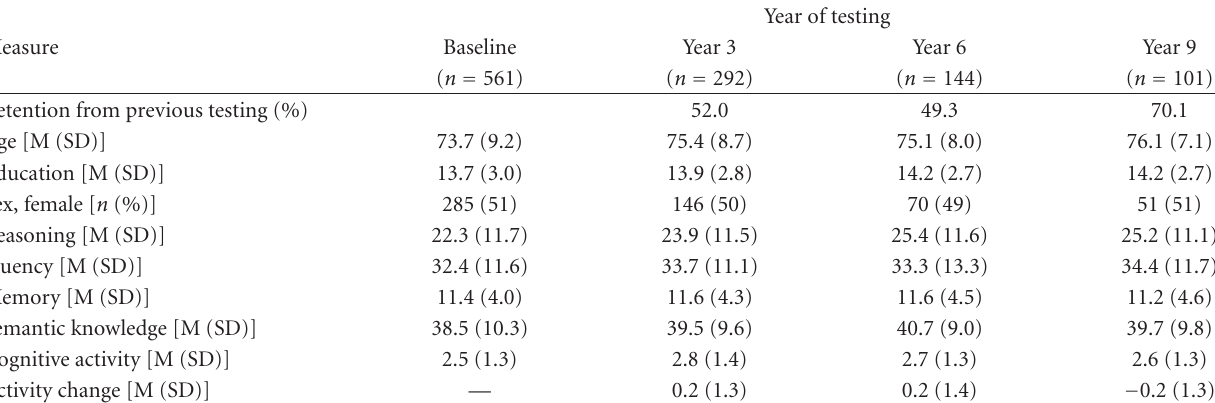
Table 2: LBLS participant characteristics.